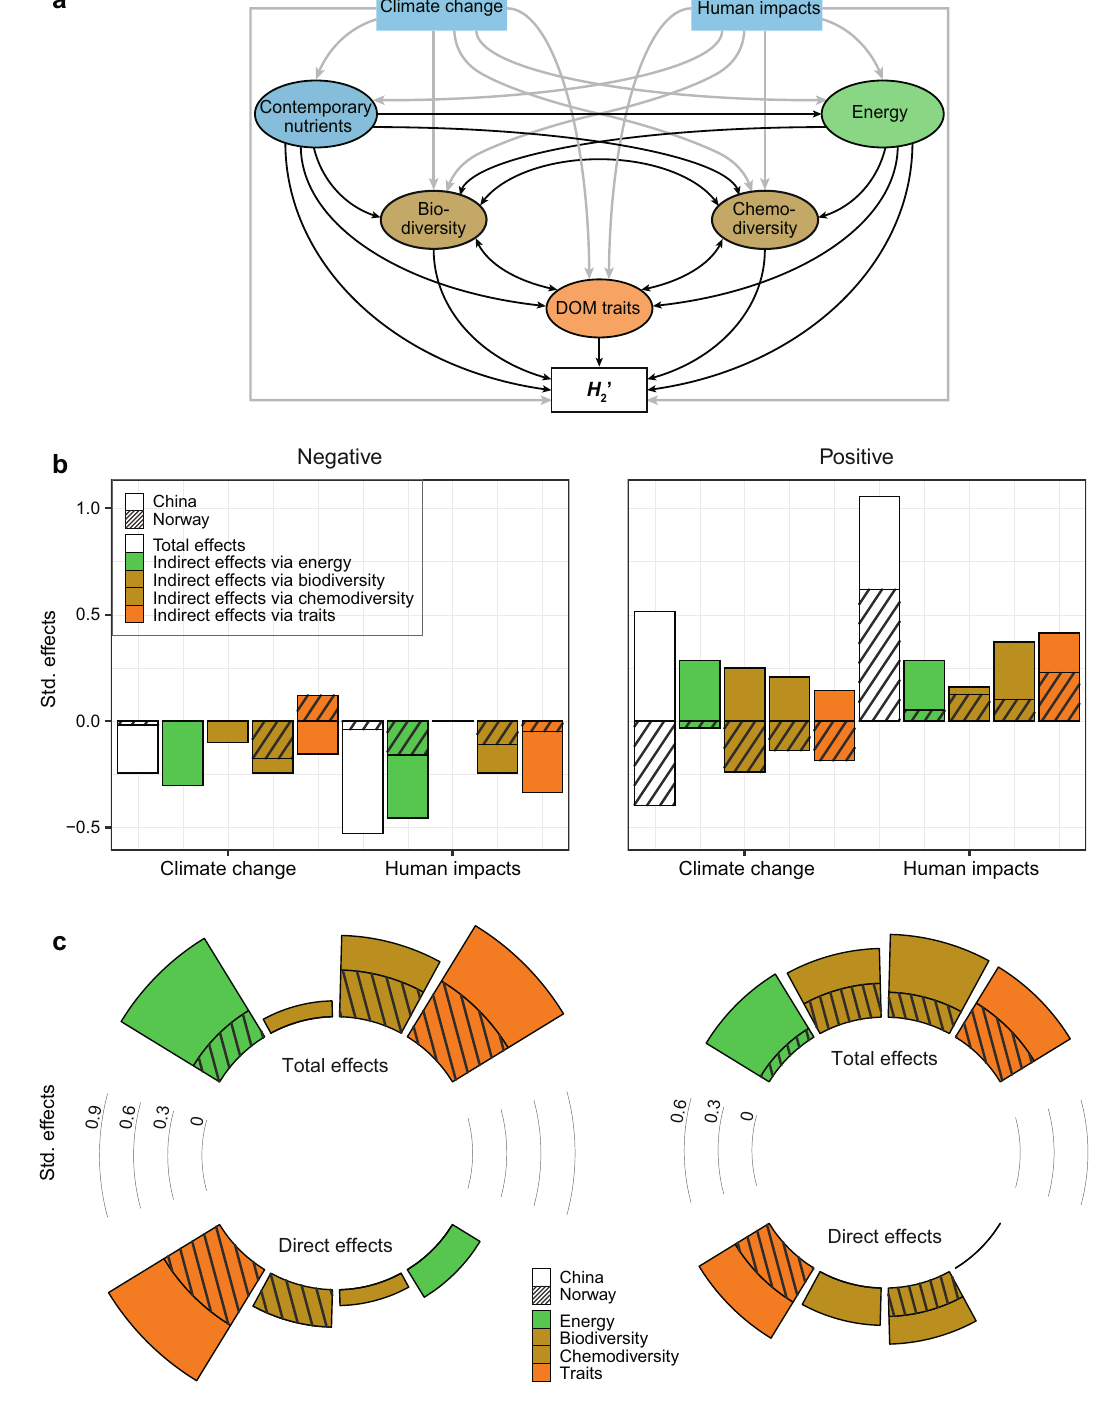
Fig. 6 Structural equation models to explain specialization of DOM-bacteria networks. a Conceptual model showing the hypothesized causal relationships among distal and proximal drivers for the specialization H 2 ′ of DOM-bacteria interaction networks. The distal drivers include climate change, human impacts and contemporary nutrients, and the proximal drivers are energy supply, biodiversity, chemodiversity and molecular traits, which are described in detail in Table S3. Grey or black arrows indicate the hypothesized relationships among the exogenous or endogenous composite variables and H ′ , respectively. b , c Stacked bar plots show the standardised effects (Std. effects) of predictor variables on the H 2 (right panel) bipartite networks in China or Norway estimated from the best supported models. We considered b the total and indirect effects of global change and human impacts via proximal variables and c the total and direct effects of proximal variables. Details of the full structural equation models are shown in Fig.